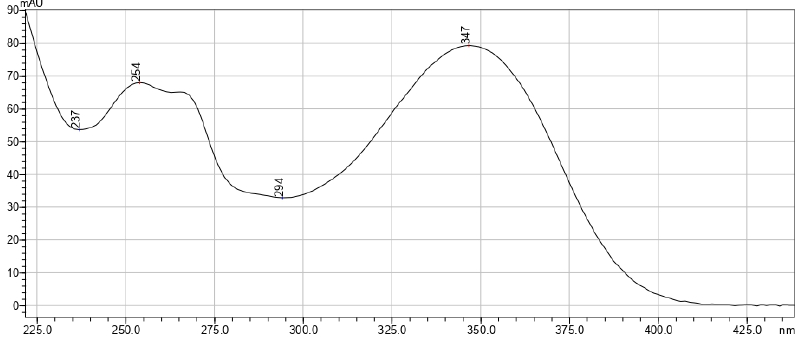
Figure 2. Absorption spectrum of luteolin-7-glucoside isolated from T. vulgare extracts.